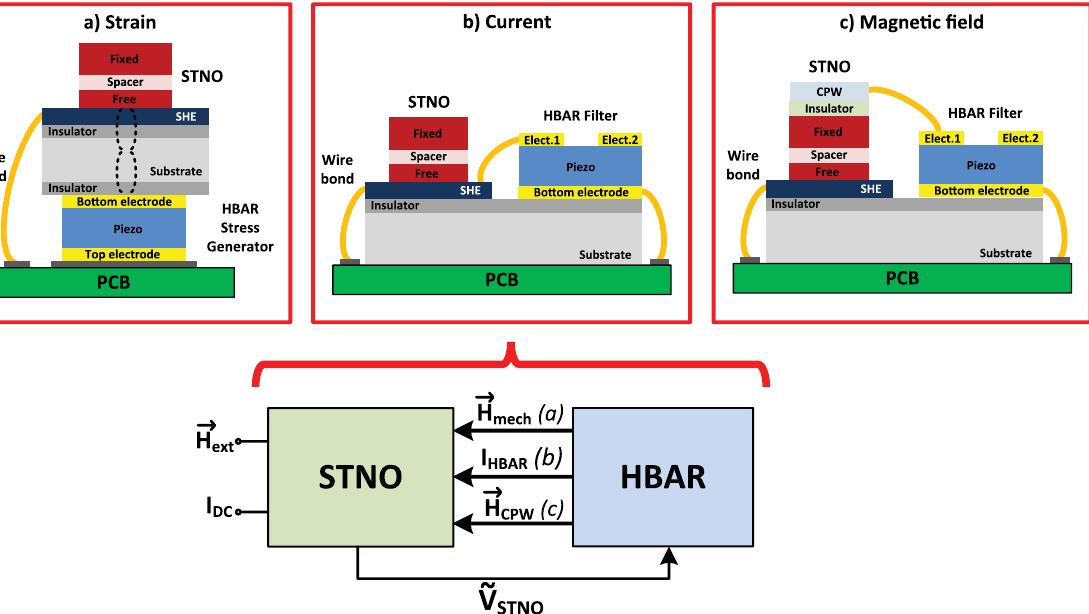
Figure 1. Magneto acoustic spin Hall oscillators that combine the tunability of the standard STNO with high Q of the HBAR on a single chip. Voltage oscillations across a three-terminal MTJ is shaped by the transmission response of the HBAR and fed back to the MTJ after a certain delay using ( a ) strain, ( b ) current, or ( c ) magnetic field via a CPW (coplanar waveguide), causing high Q filtering and delayed feedback. Proposed concept shows a significant enhancement in the linewidth with all feedback methods, simultaneously preserving the key frequency tunability feature of